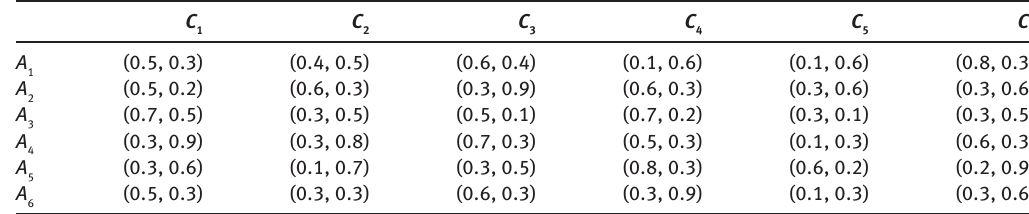
Table 1: Characterization of the Investments of Expert